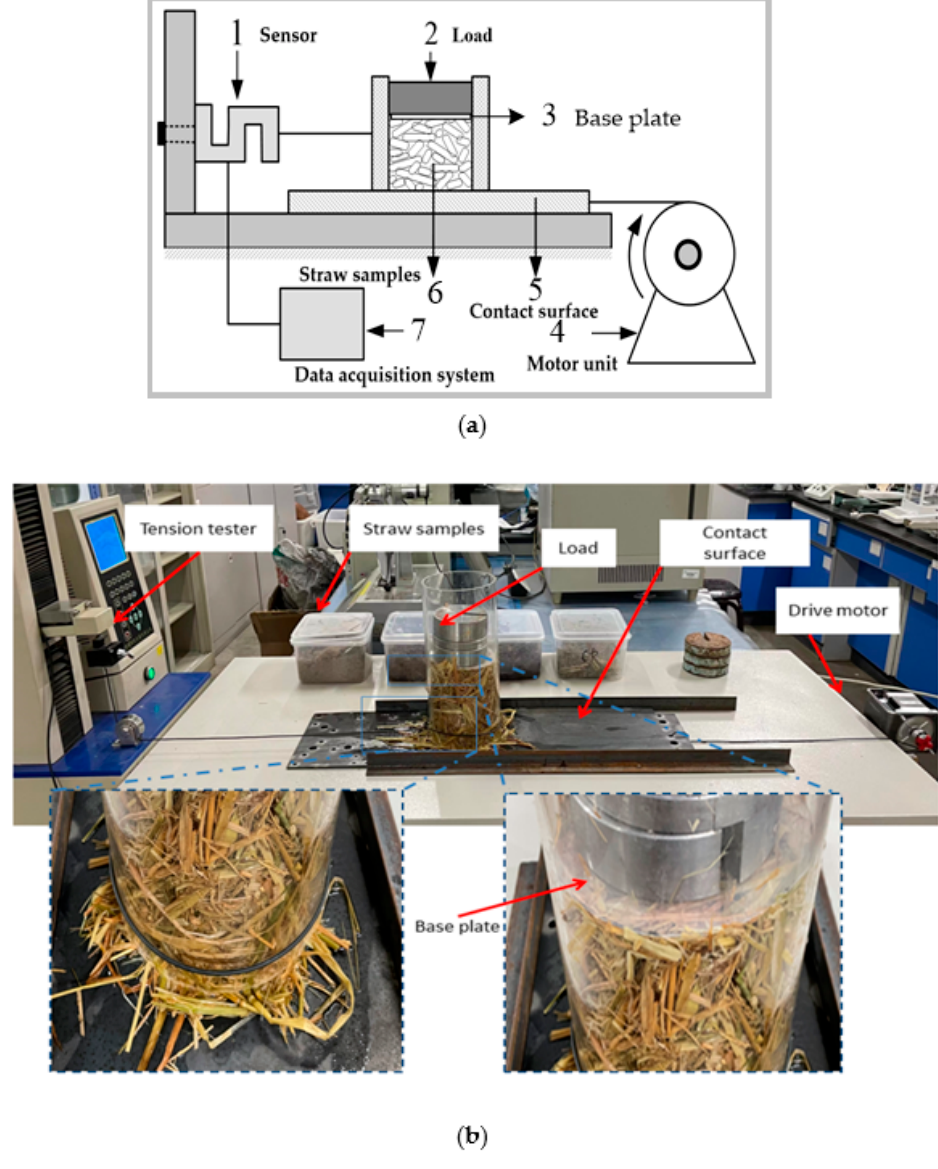
Figure 2. Schematic of the sliding friction test apparatus and test scene diagram (( a ): schematic diagram of device; ( b ): test scene diagram).